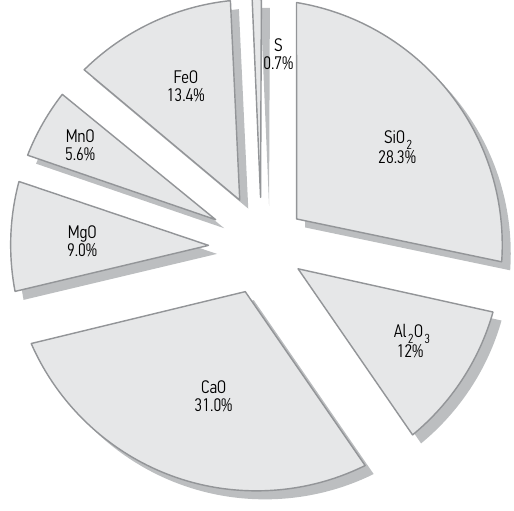
Fig. 1. Chemical compound of electric furnace steel-smelting slag Table 2. Slag